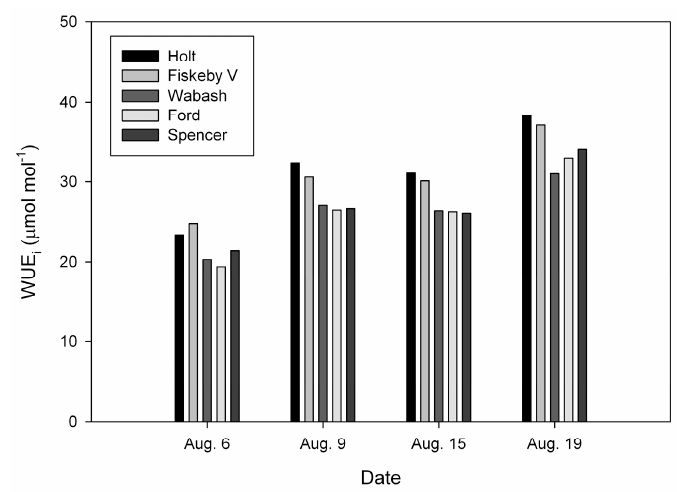
Figure 2. Intrinsic leaf water-use efficiency (WUE i ) in five cultivars of soybeans measured on four dates in 2018. Air temperatures (°C) during the measurements on each date are provided.